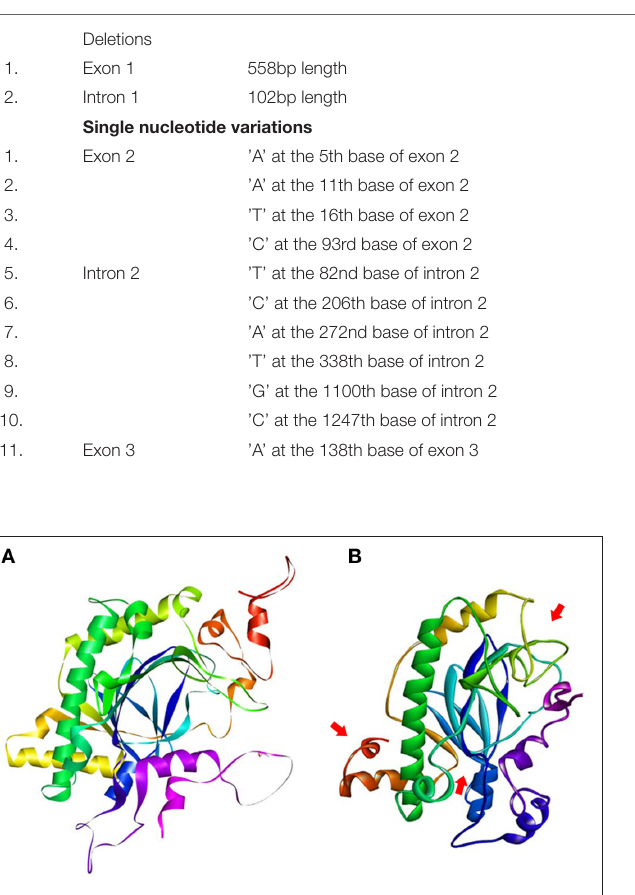
TABLE 3 | Details of mutations in the OsGA20ox2 gene of WP-22-2. S.No.